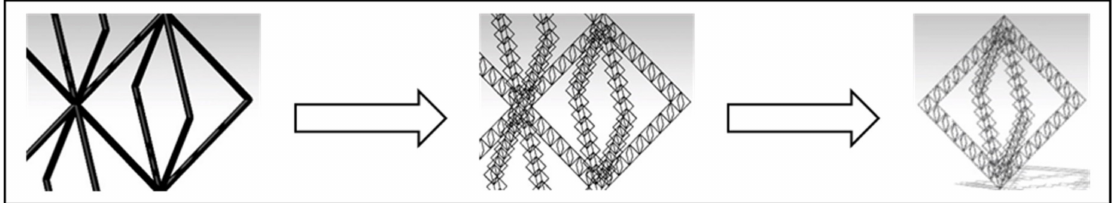
Figure 2. Three different scales of the structure. ( Left ) First Scale: small octahedron (“cell”), ( Center ) Second scale: octaedron lattices, ( Right ) Third scale: octahedron structure.